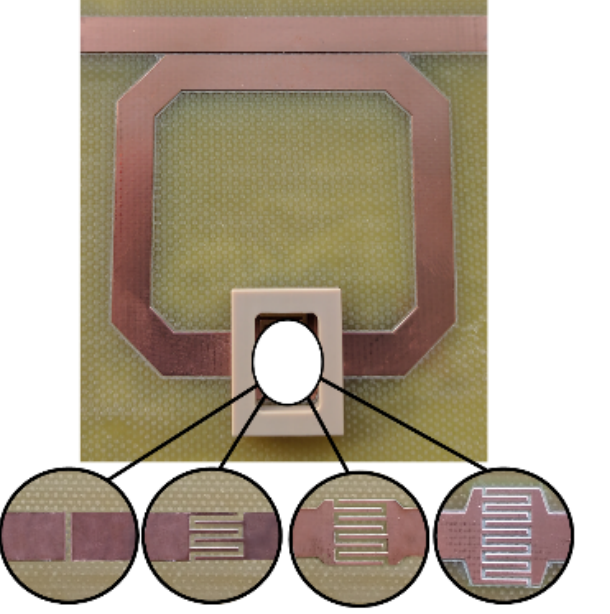
Figure 10. Split-ring resonator with different split capacities.